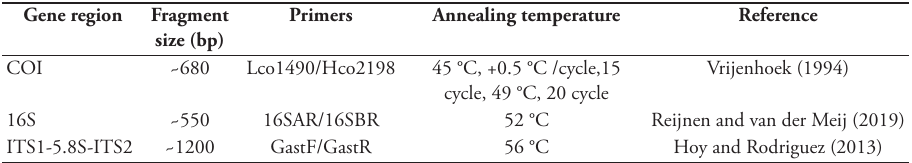
Table 1. Details of gene regions and associated primer pairs used in the study. Gene region Fragment size